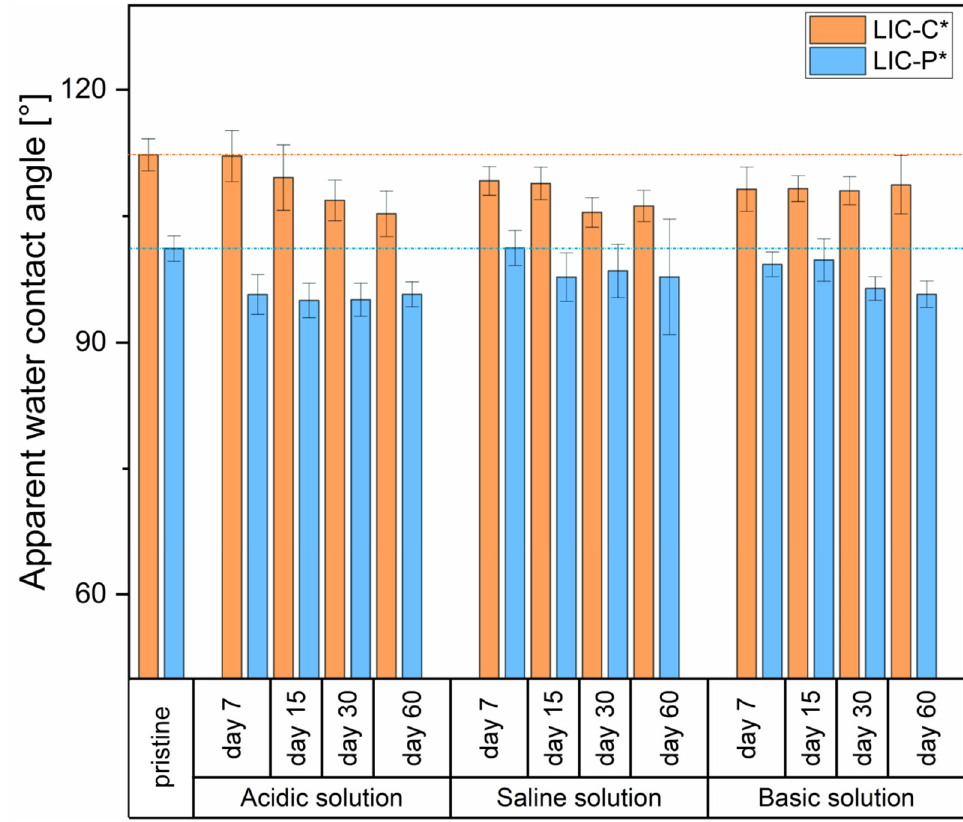
Figure 10. The apparent water contact angle of LIC-C* and LIC-P* samples before and after ageing in acidic, saline, and basic solutions.